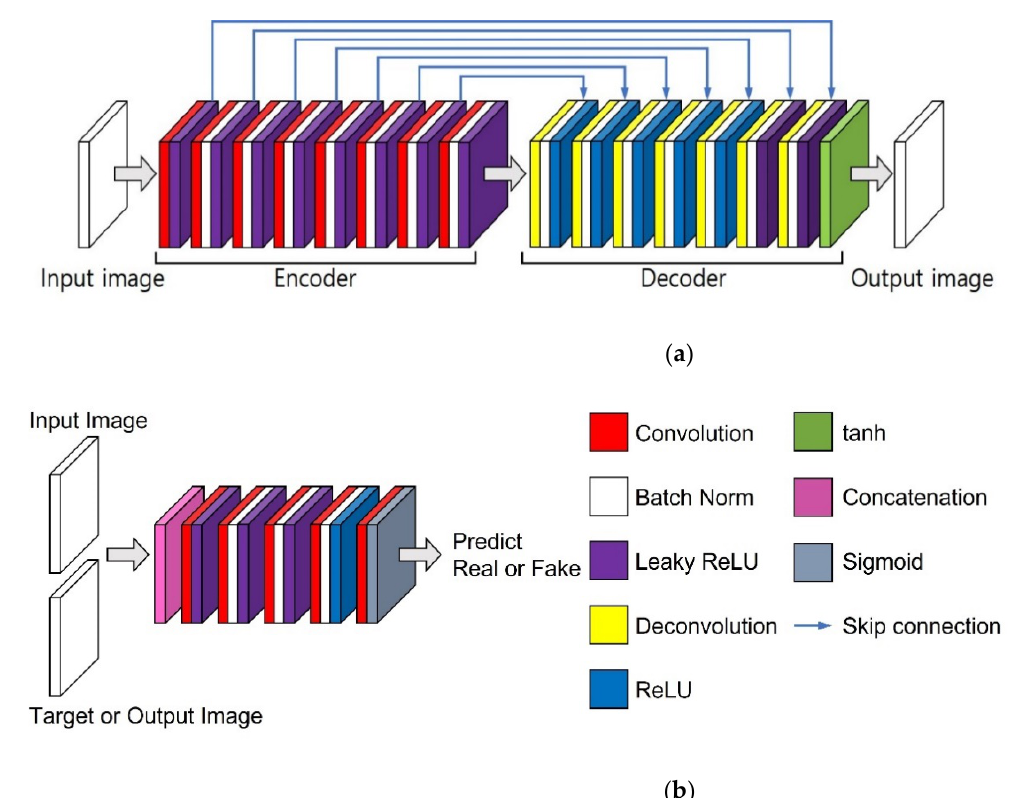
Figure 3. The structure of LAE-GAN. ( a ) Generator. ( b ) Discriminator. The generator uses a U-net architecture that combines an encoder-decoder structure with a skip-connection. The discriminator consists of convolutional layers that receive a concatenated image. Detailed explanations are given in Sections 3.3.1 and 3.3.2.